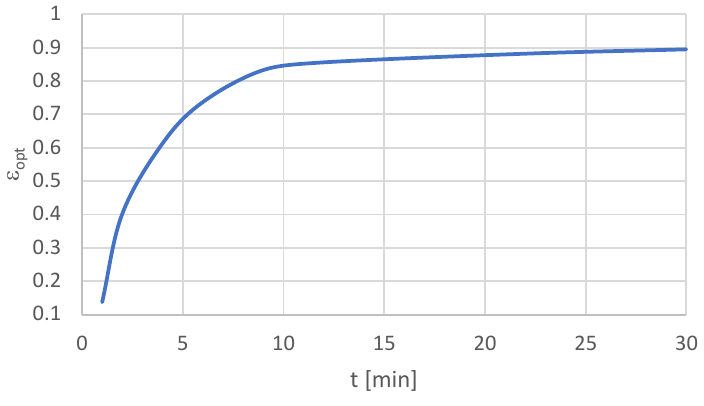
Figure 4. Relation ε opt (t). Figure 4. Relation  opt (t).